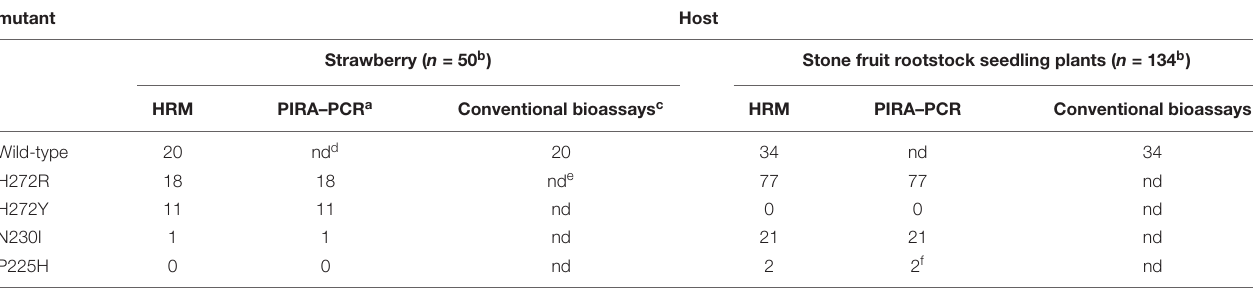
TABLE 2 | Determination of resistance to boscalid and detection of sdh B mutations using high resolution melting (HRM) analysis, PIRA–PCR, and conventional bioassays in B. cinerea samples obtained from infected strawberry fruit and stone fruit rootstock seedling plants showing damping-off